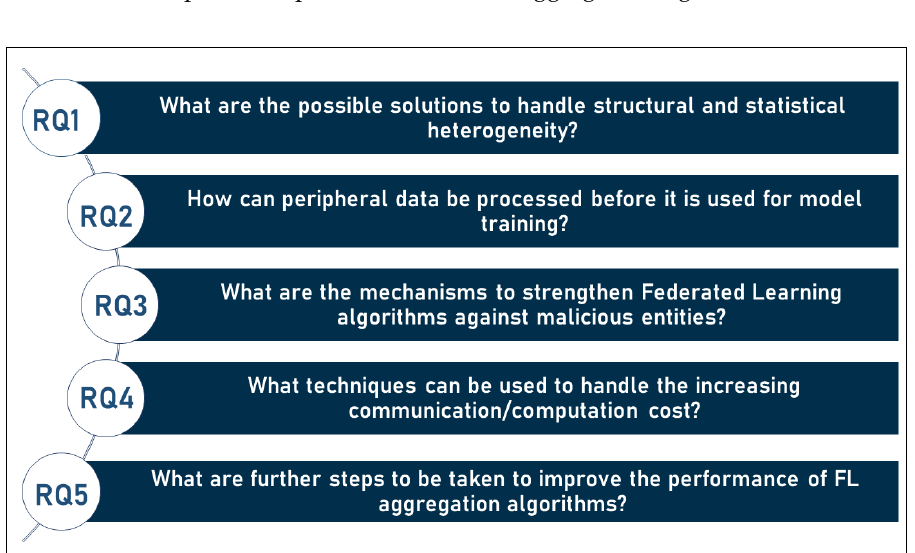
Figure 8. Research questions arising from analyzing the usage of FL in disease